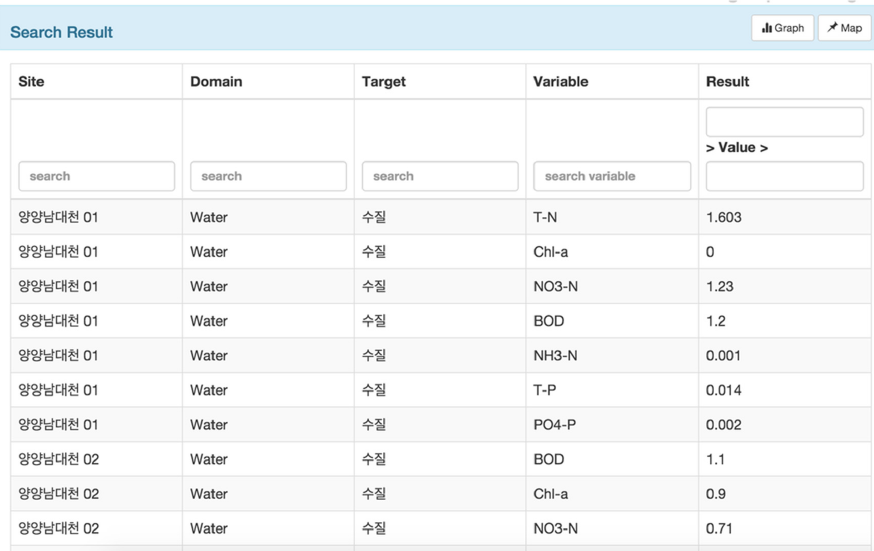
Figure 13. Observation data collected at selected sites.